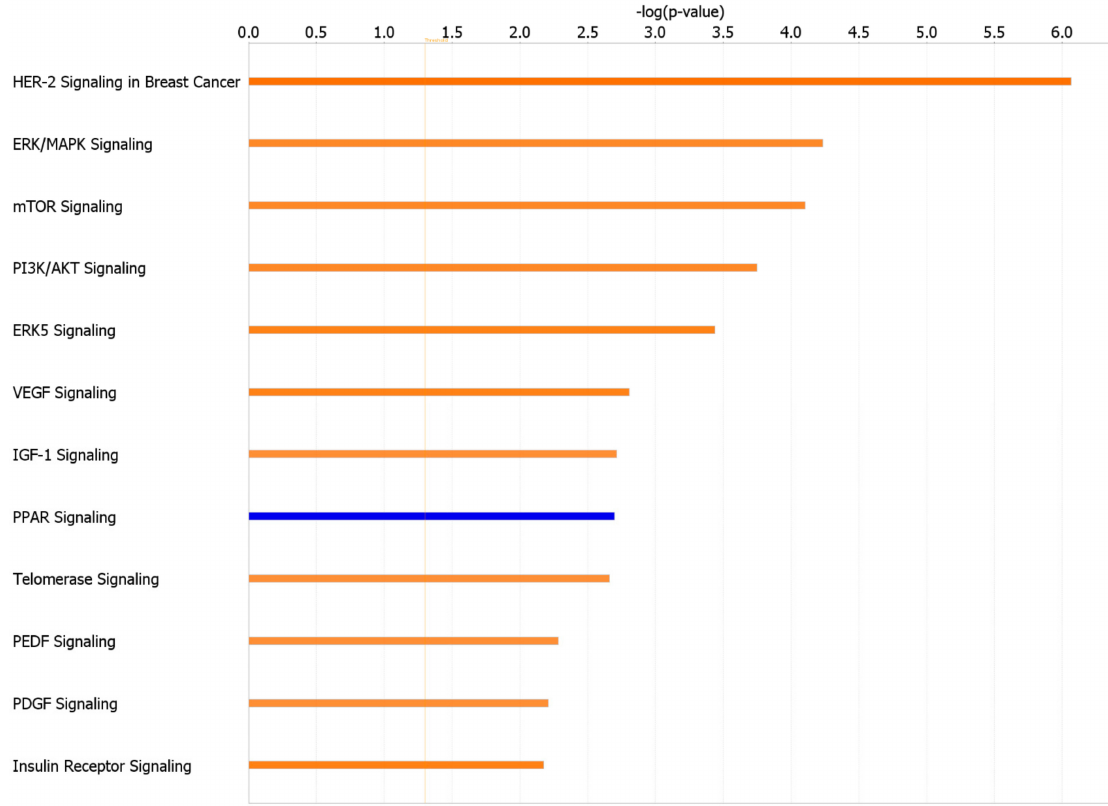
Figure 7. Top canonical pathways in terminal ileum affected by HA 35 KDa supplementation, ranked by Z-score with a cutoff ≥ 2 (orange, activated) and ≤− 2 (blue,